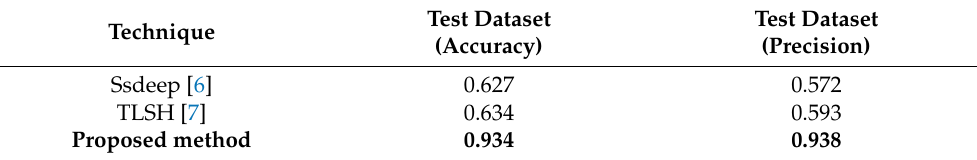
Figure 12. Visualization of test dataset using PCA. Table 5. Classification model performance comparison with previous